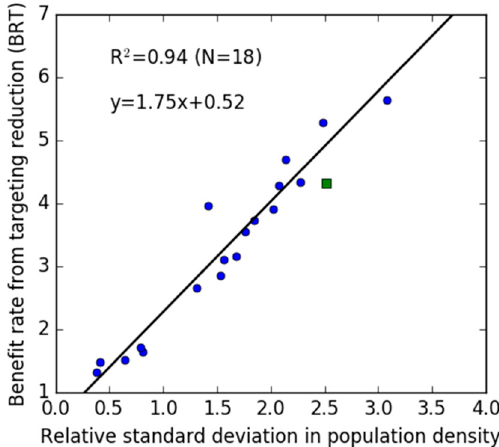
Figure 9. Relationship between the BRT value and relative standard deviation of population density for eighteen districts of Hong Kong. Each blue point represents a specific district. The green square represents Hong Kong.